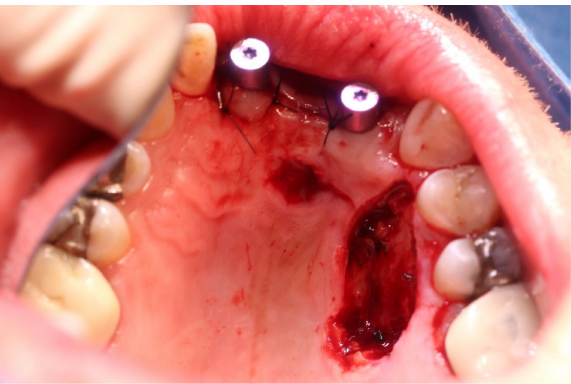
Figure 7. Condition after resection of the second recurrence and exposure of the implants: the changes in the oral mucosa were resected with safety margins. The implants in regions 12 and 21 were exposed and restored with gingival